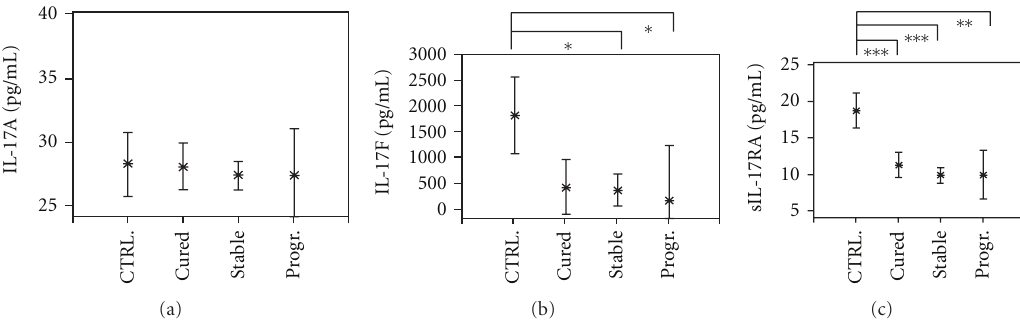
Figure 2: Plasma concentrations of interleukin (IL)-17A (part a) and IL-17F (part b) and of soluble IL-17RA (part c) in Alveolar Echinococcosis (AE) patients and infection-free controls (CTRL). Patients were grouped according to their state of infection, that is, cured, stable, or progressive (Prog.) Alveolar Echinococcosis. The plasma concentrations are shown as the mean values in pg/ml with the 95% upper and lower confidence interval. The level of significance was adjusted by the Bonferroni-Holm method. Significant di ff erences between the groups are indicated ( ∗ P < 0 . 05, ∗∗ P < 0 . 01, and ∗∗∗ P < 0 . 001).